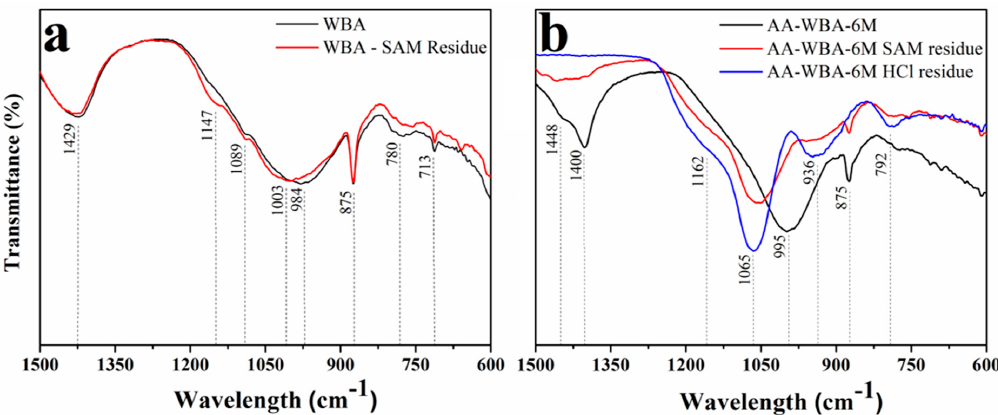
Figure 8. FTIR spectra before and after SAM extraction of ( a ) WBA and ( b ) AA-WBA-6M.